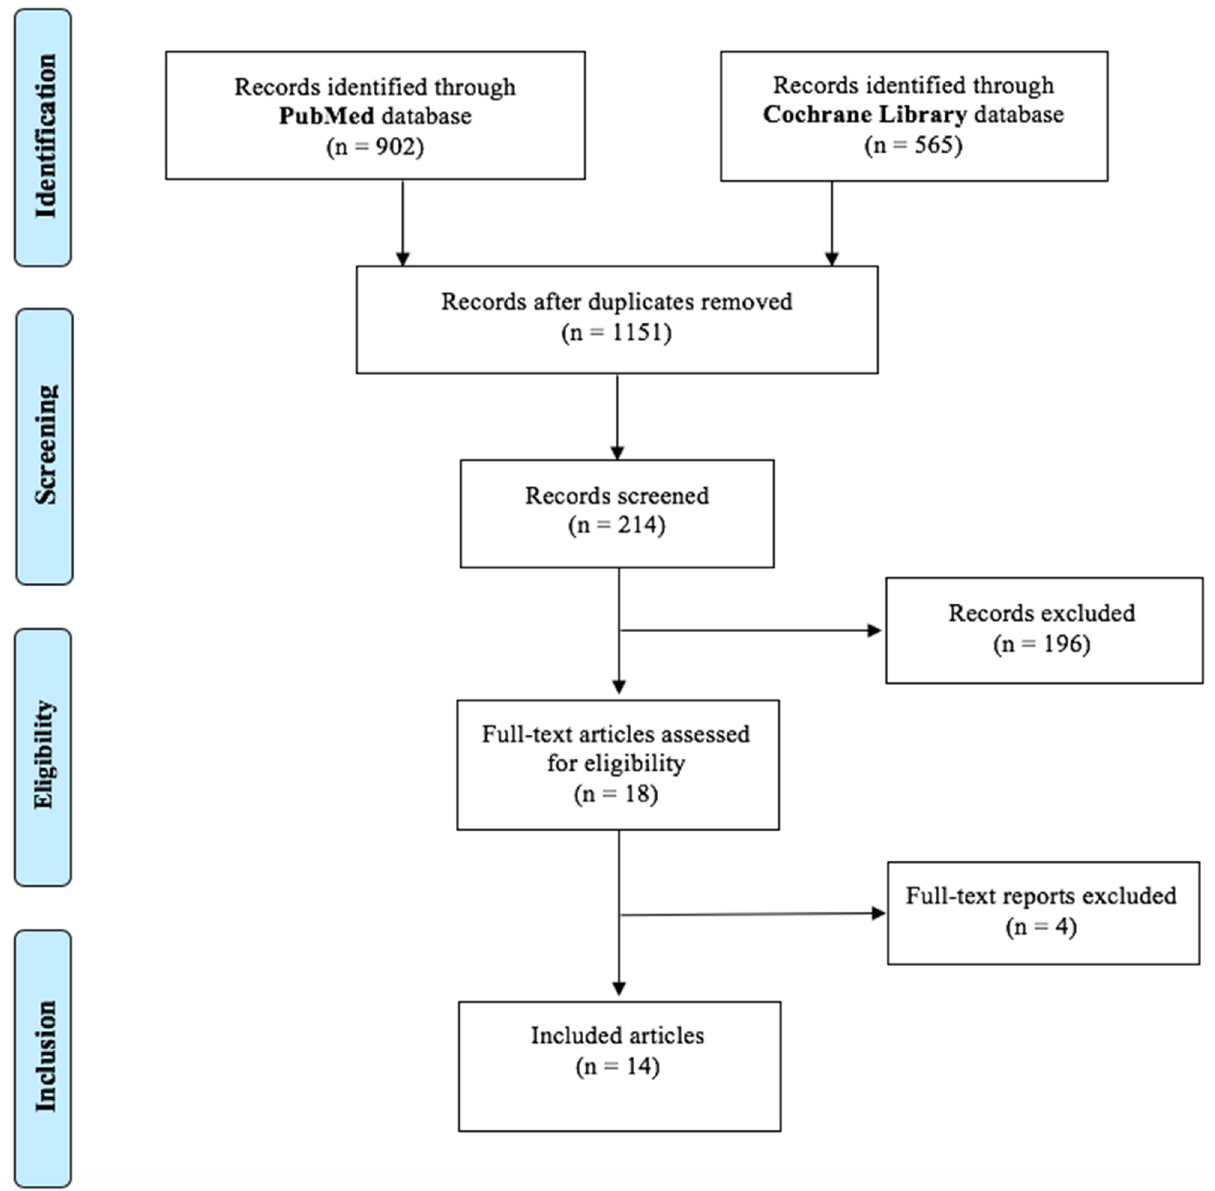
Figure 2. Flow chart of study selection.